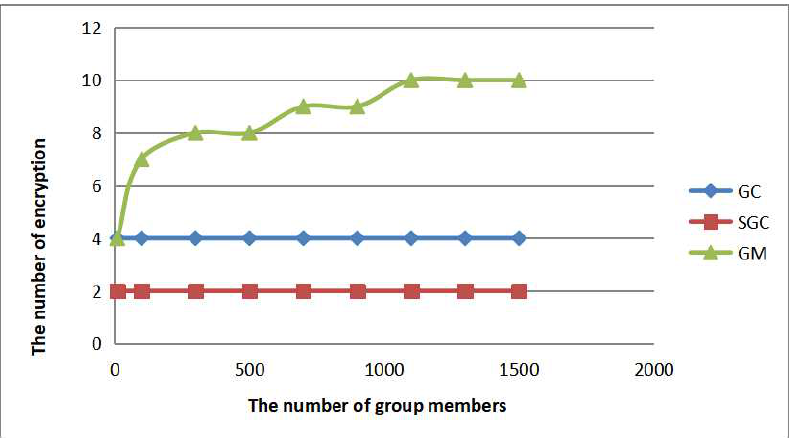
Figure 8. Computational overload of GC, SGC, and GM when a member